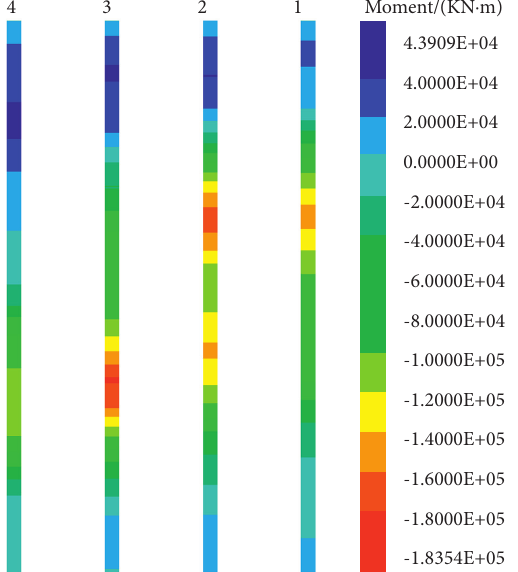
Figure 20: Cloud diagram of bending moment of bridge pile